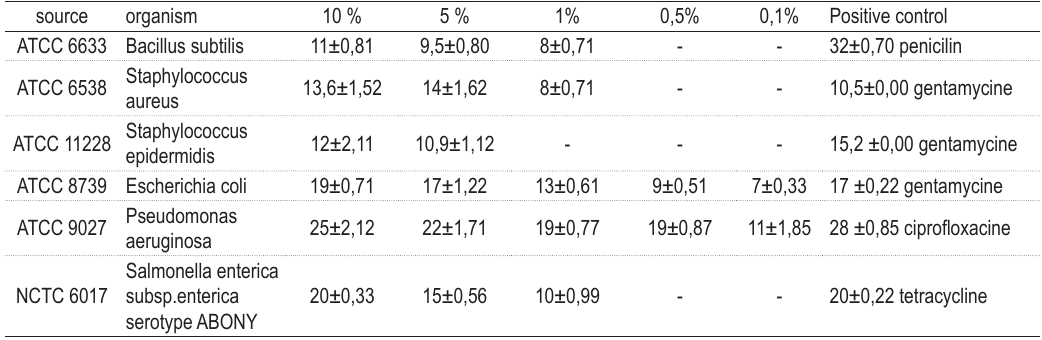
TABLE 2. Antibacterial Activity (Inhibition Zone Measured in mm, Including Hole 6 mm in Diameter) of Essential Oils of Mentha longifolia